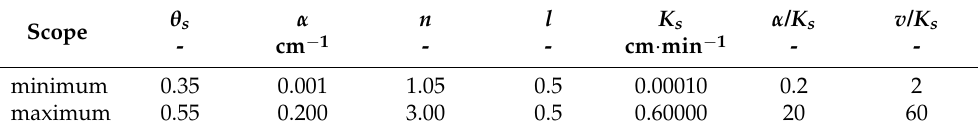
Figure 2. Relationships between selected soil hydraulic parameters: ( a ) α -K s ; ( b ) α -n , and ( c ) vK s . Table 2. Inverse scope of soil hydraulic